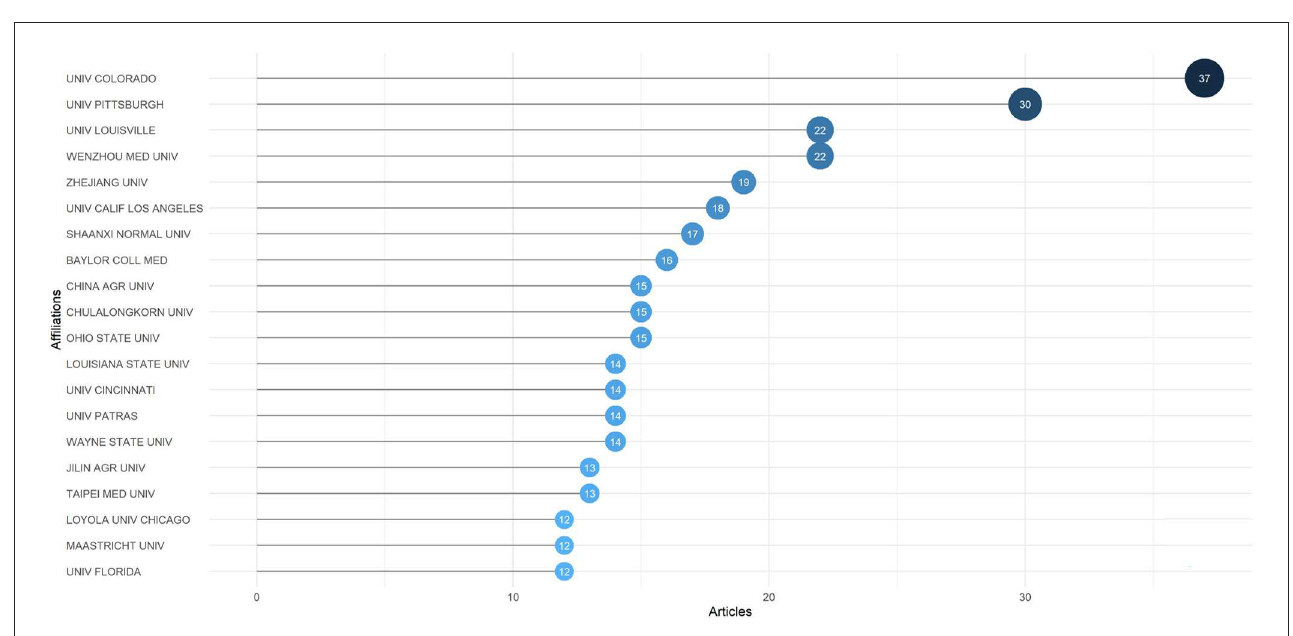
FIGURE4 Top 20 most productive institutions in gut microbiota and trauma research.